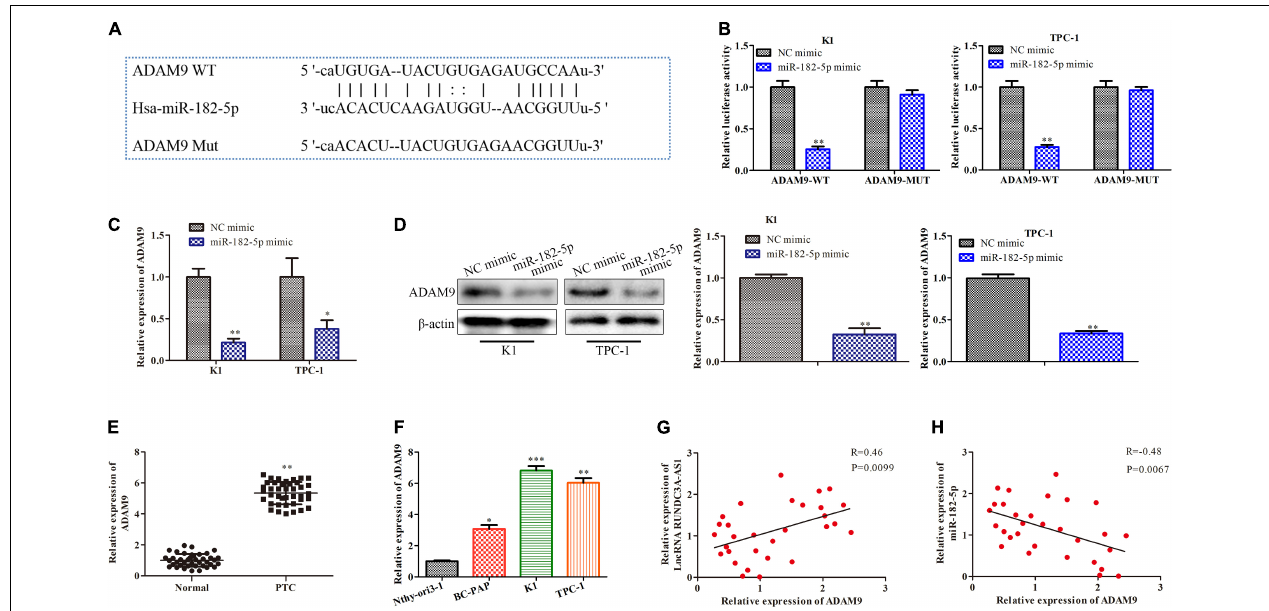
FIGURE 5 | MiR-182-5p targets ADAM9 and causes posttranscriptional suppression. (A) The predicted miR-182-5p binding sites in the region of ADAM9 and the corresponding mutant sequence were shown. (B) Relative values of luciferase signal. (C) The expression level of ADAM9 both in K1 and TPC-1 cells after transfected with NC mimic and miR-182-5p mimic, respectively. (D) Western blot analysis of the expression level of ADAM9 protein. * P < 0.05, ** P < 0.01 vs. the NC mimic group. (E) The expression level of ADAM9 in tumor and para-carcinoma tissues. ** P < 0.01 vs. the normal group. (F) The expression level of ADAM9 in normal thyroid cells and thyroid cancer cell lines. ** P < 0.01, *** P < 0.005 vs. the Nthy-ori3-1 cell line. (G) A positive correction between lncRNA RUNDC3A-AS1 and ADAM9 expression. (H) A negative correction between miR-182-5p and ADAM9 expression. The data were presented as mean ± SD and the experiments were repeated 3